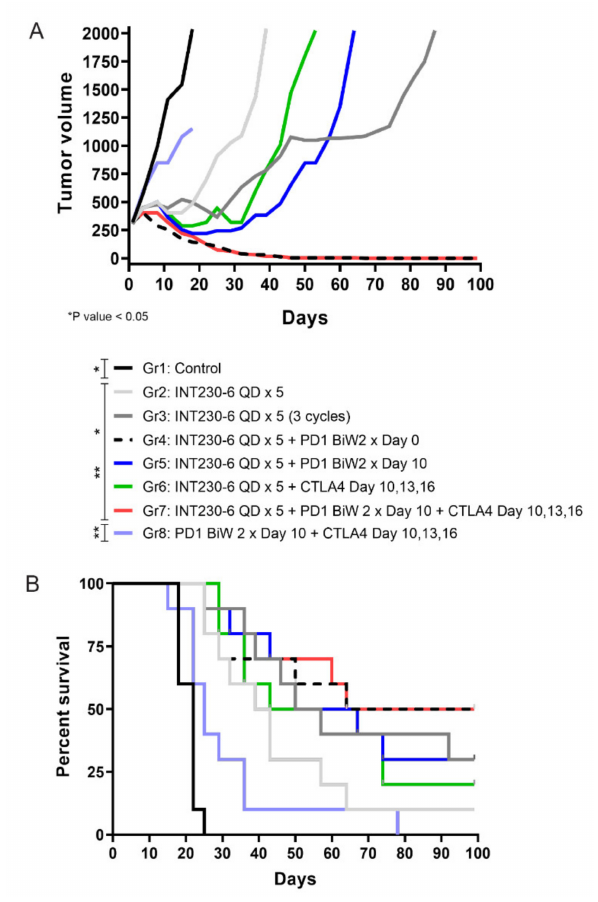
Figure 7. E ff ects of INT230-6 alone and in combination with checkpoint inhibitors (CTLA-4 and / or PD-1 antibodies) on median tumor volume in mice bearing Colon-26 tumors. ( A ) There were ten (10) animals per group. The median tumor volume was chosen to better represent the tumor growth curves of BALB / c mice for the full length of the study (100 days). The following animals were found dead in the cages and removed from the study for a better representation of the tumor growth curves: Group 1 (1 Animal), Group 2 (3 animals), Group 3 (2 animals), Group 4 (1 animal), Group 5 (1 animal), Group 6 (1 animal), Group 7 (1 animal), Group 8 (1 animal). Because mice died at di ff erent times during the study, statistical analysis was conducted with two-way ANOVA at day 22 (latest available data for the control group 1). At this time, INT230-6-treated groups had statistically significant reduced tumor growth curves when compared to either Group 1 (Control) or Group 8 (anti-PD-1 + anti-CTLA-4) ( p value < 0.05). ( B ) Kaplan–Meier survival curves showing that the addition of anti-PD-1 antibodies to a single cycle (QDx5) of INT230-6 treatment, increased the number of CR animals from 1 / 7 (14%) (Group 2) to 5 / 9 (55%) (Group 4). A similar result was obtained in Group 7 (INT230-6 + anti-PD-1 + anti-CTLA-4), where 5 / 9 mice had CR (55%) considering that CTLA-4 alone added limited benefits in combination with INT230-6; 2 / 9 CR in Group 6 (22%). The log rank (Mantel-Cox) test showed statistical di ff erences between groups treated with INT230-6 and Group 1 and Group